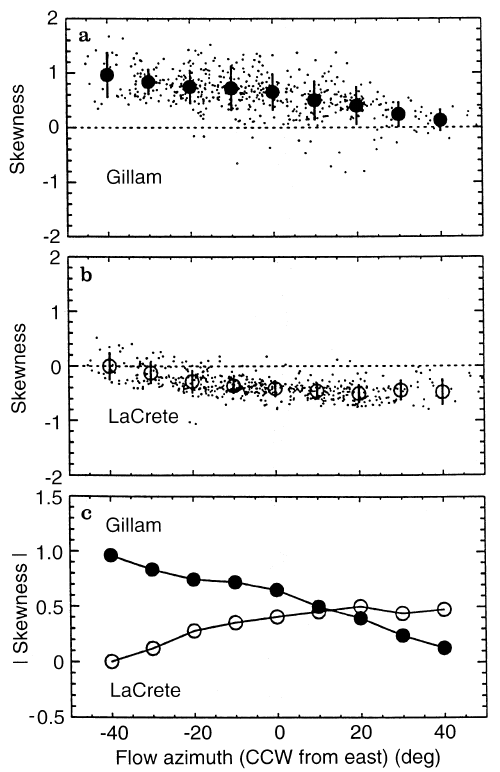
Fig. 6a–c. Dependence of the skewness versus the electron flow azimuth: a Scatterplot of skewness versus azimuth at the Gillam- Saskatoon link and the trend in this dependence ( large circles ); b the same has a , but for the LaCrete-Saskatoon link; c comparison of the trends on the G-S and